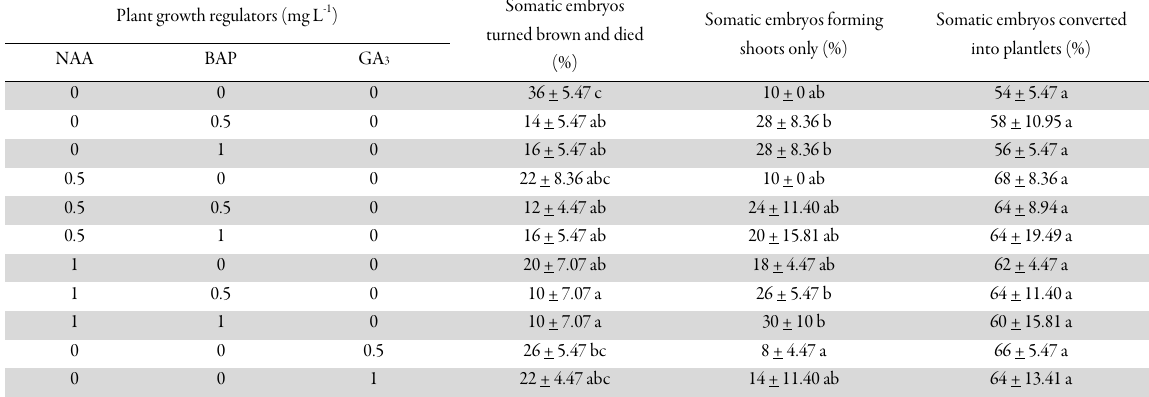
Table 4. Effects of plant growth regulators on somatic embryo germination Plant growth regulators (mg L -1